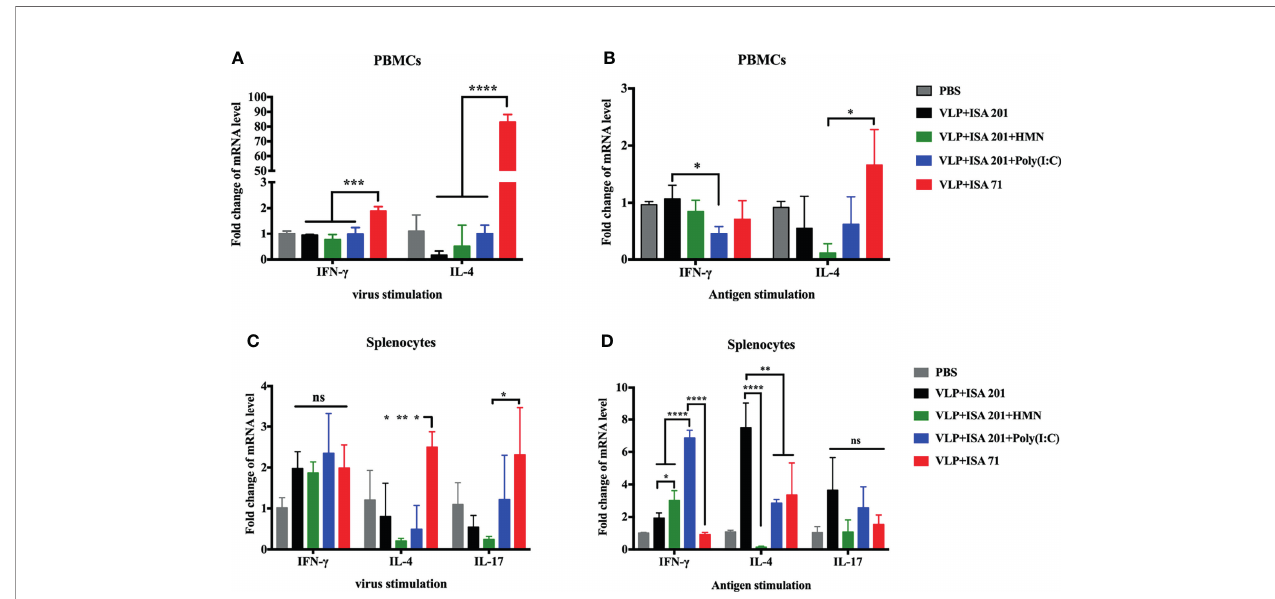
FIGURE 7 | Cytokine expression levels in PBMCs and splenocytes of SPF chickens (N=3). PBMCs and splenocytes were isolated from the vaccinated chickens 19 days after immunization and stimulated with inactivated in fl uenza virus or puri fi ed H7N9 VLPs antigen for 8 h in vitro. The expression levels of cytokines in PBMCs (A, B) and splenocytes (C, D) were measured using qRT-PCR. Data are presented as the mean ± standard error of the mean. Statistical signi fi cance of differences is illustrated as follows: *P < 0.05, **P < 0.01, ***P < 0.001, ****P < 0.0001, or ns, not signi fi